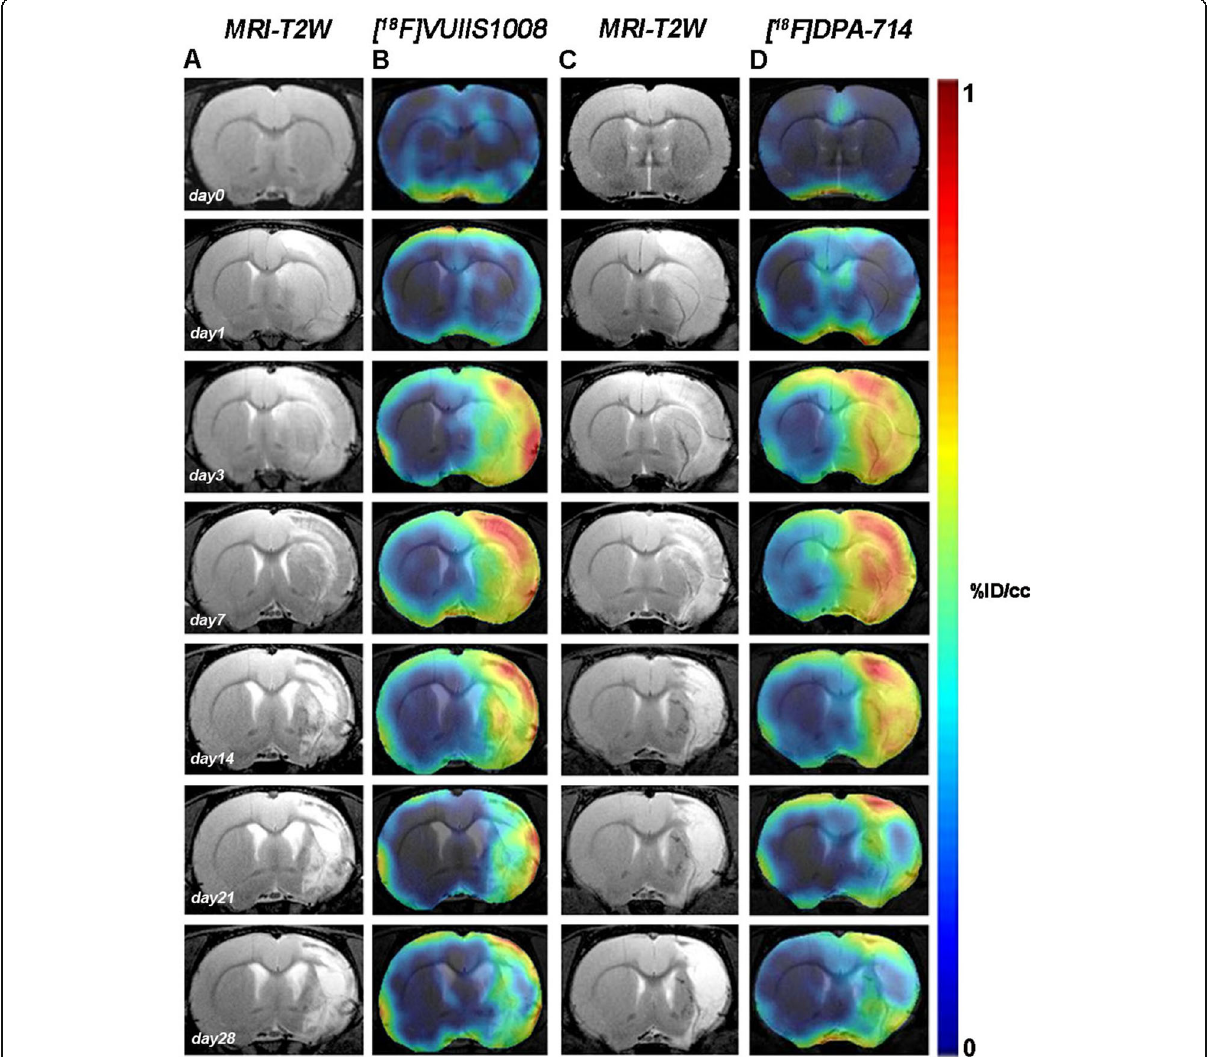
Fig. 1 Magnetic resonance imaging (MRI) (T2-weighting (T 2 W)) and positron-emission tomography (PET) images of [ 18 F] VUIIS1008 and [ 18 F] DPA-714 at control (day 0) and days 1, 3, 7, 14, 21, and 28 after the middle cerebral artery occlusion (MCAO). Serial MRI (T 2 W) ( a , c ) and TSPO PET binding ( b , d ) images of coronal planes at the level of the lesion are shown. PET images are co-registered with the MRI (T 2 W) of the same animal at different times to localize the PET signal. Images correspond to the lesion evolution of the same animal over